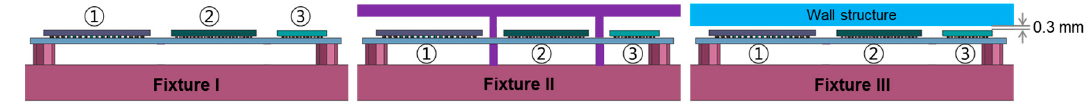
Figure 4. Schematic of three fixtures for various BGA boundary conditions.